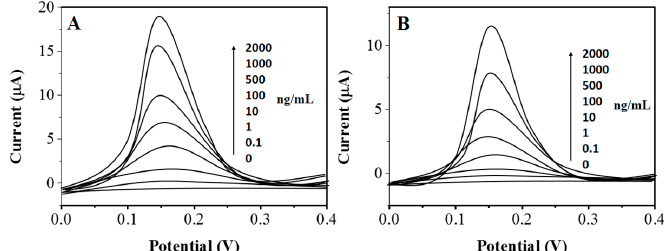
Figure 5. Representative differential pulse voltammetric (DPV) curves of the AP-anti-IgG/AuNP- RGO/anti-NSE/NSE/GCE ( A ) and the alkaline phosphatase (AP)-anti-IgG/anti-NSE/NSE /GCE ( B ) obtained with NSE in a concentration of 0, 0.1, 1, 10, 100, 500, 1000, and 2000 ng/mL.